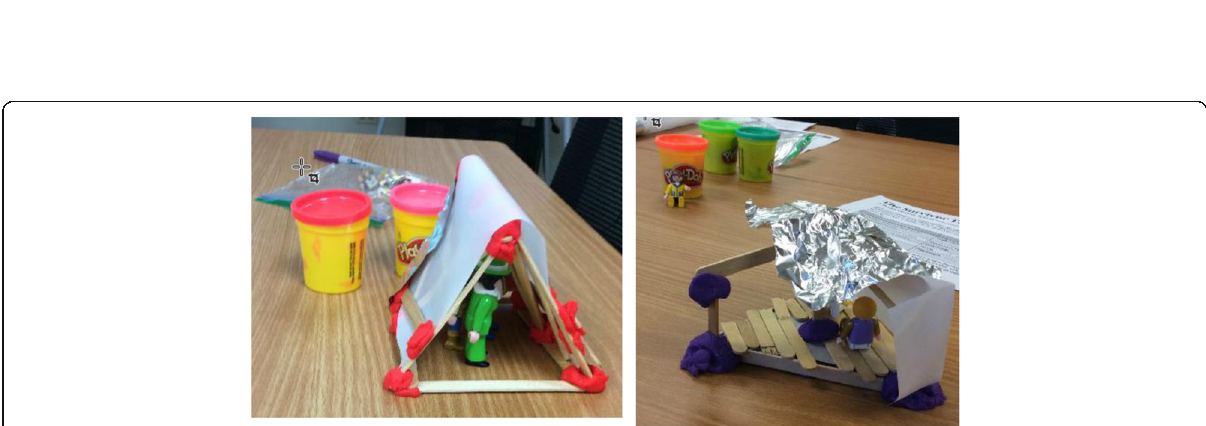
Fig. 1 Survivor MEA summary and design feature alignment (adapted from http://wordpress.unlvcoe.net/wordpress/wp-content/uploads/2013/ 01/Survivor-MEA-Teacher-Materials.pdf)